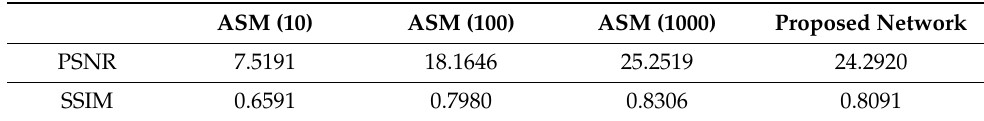
Table 2. Performance evaluation of reconstruction results of different methods. ASM (10) ASM (100) ASM